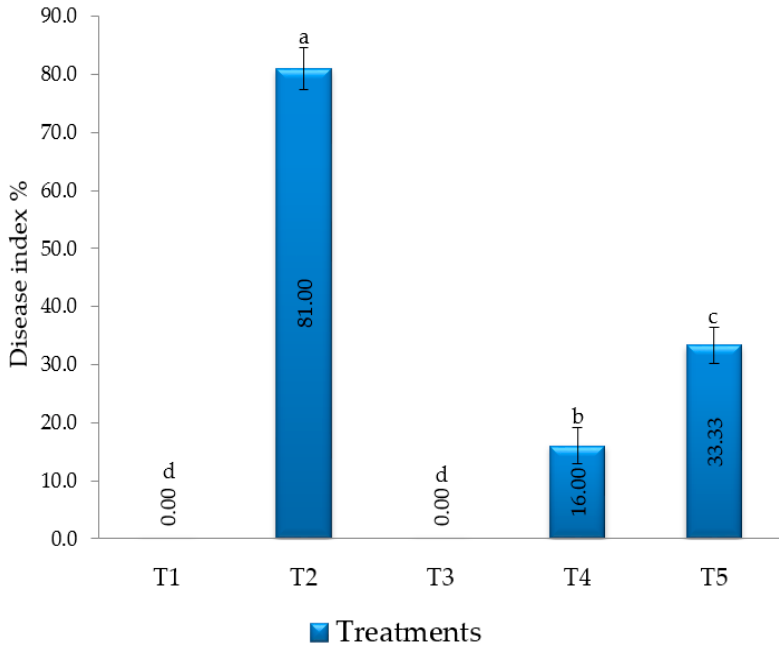
Figure 5. Disease index % in tomato caused by R. solani Rs33 under greenhouse conditions. T1: tomato plant control inoculated with media-free microorganisms; T2: tomato plants inoculated with R. solani only; T3: tomato plants inoculated with T. asperelloides ; T4: tomato plants inoculated with T. asperelloides 48 h before inoculation with R. solani (protective application); T5: tomato plants inoculated with T. asperelloides 48 h after inoculation with R. solani (curative application) . Data with the same letters are not significantly different at p ≤ 0.05.